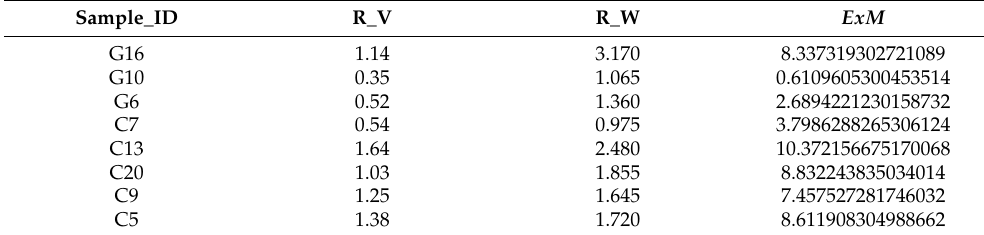
Table 3. Sample of the ( ExM ) values with respect to the real